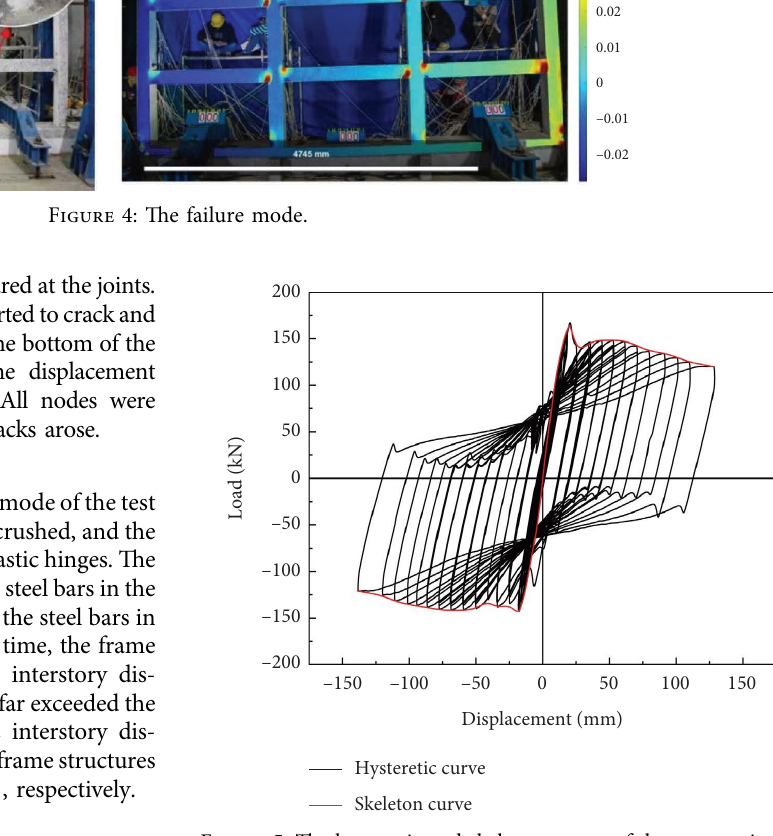
Figure 5: /e hysteretic and skeleton curves of the test